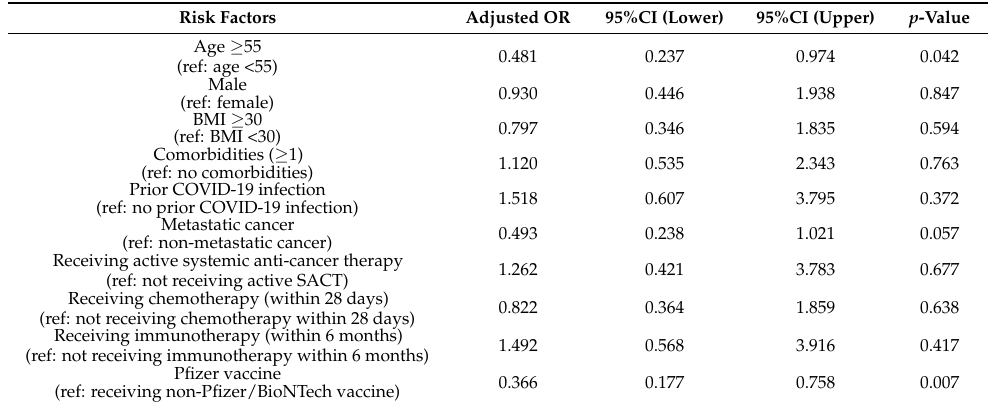
Table 6. Risk of any grade ≥ 2 vaccine-related adverse events ( n = 349). SACT, systemic anti-cancer therapy.